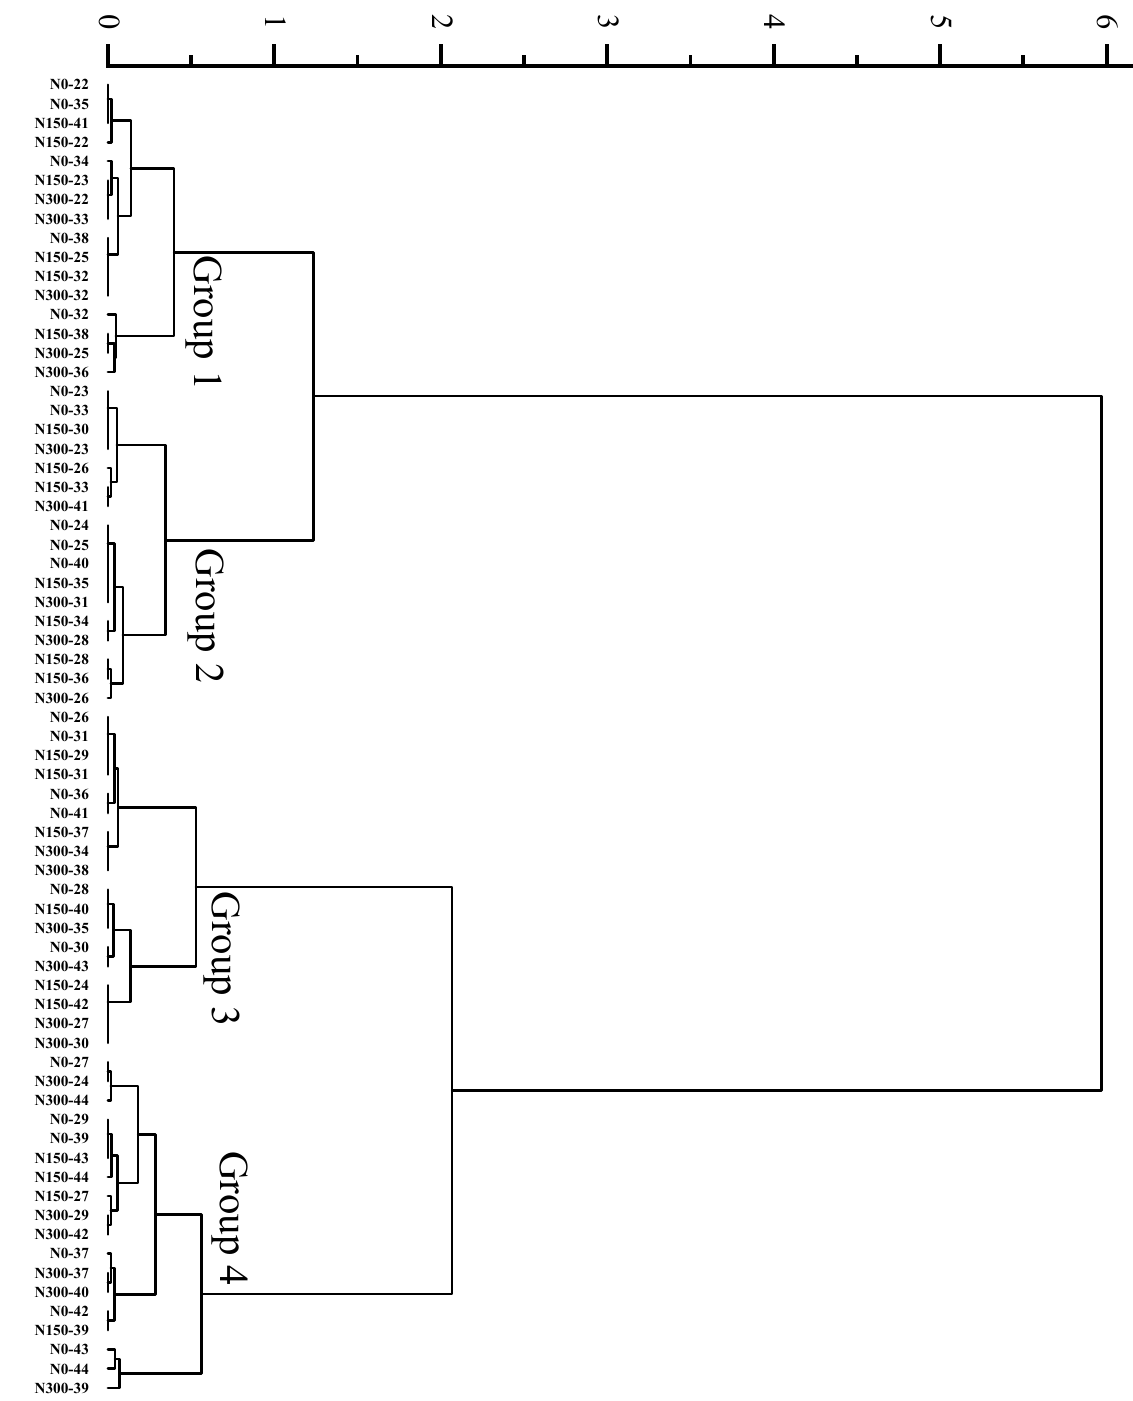
Figure 6. Cluster analysis of D values of various inbred japonica rice varieties under different nitrogen fertilizer conditions. Group 1 refers to the highest D value type, followed by Groups 2, 3, and 4. For hybrid indica rice, the sum proportion of rice samples in the N0 subset of Groups 1 and 2 was higher than that in Groups 3 and 4, and the sum proportion of rice samples in the N150 or N300 subset of Groups 3 and 4 was higher than that in Groups 1 and 2 (Figure 7a). While for inbred japonica rice, the sum proportion of rice samples in the N150 subset of Groups 1 and 2 was higher than that in Groups 3 and 4, and the sum proportion of rice samples in the N0 or N300 subset of Groups 3 and 4 was higher than that in Groups 1 and 2 (Figure